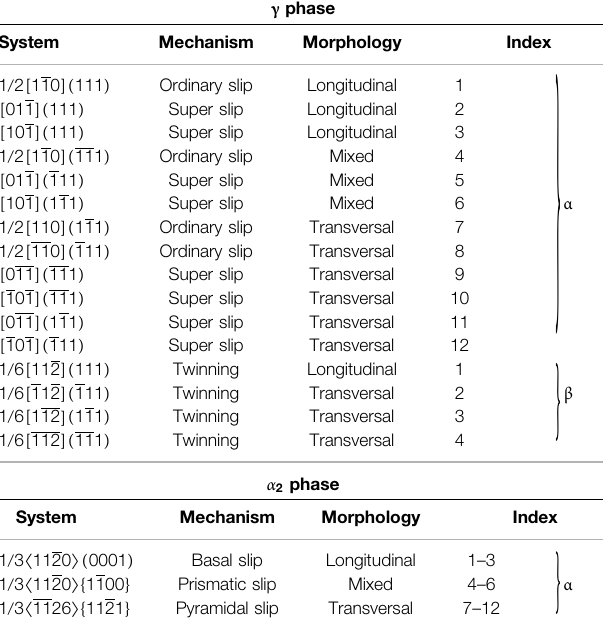
TABLE 1 | Slip and twinning systems in the tetragonal γ and hexagonal α 2 phase with morphological classi fi cation according to Lebensohn et al. (1998). Although both phases exhibit a c ratio ≠ 1, standard Miller index, respectively, a Miller-Bravaisindexnotationisusedforabetterreadability.Throughoutthisarticle, the index α is used for slip systems, whereas the index β is used for twinning